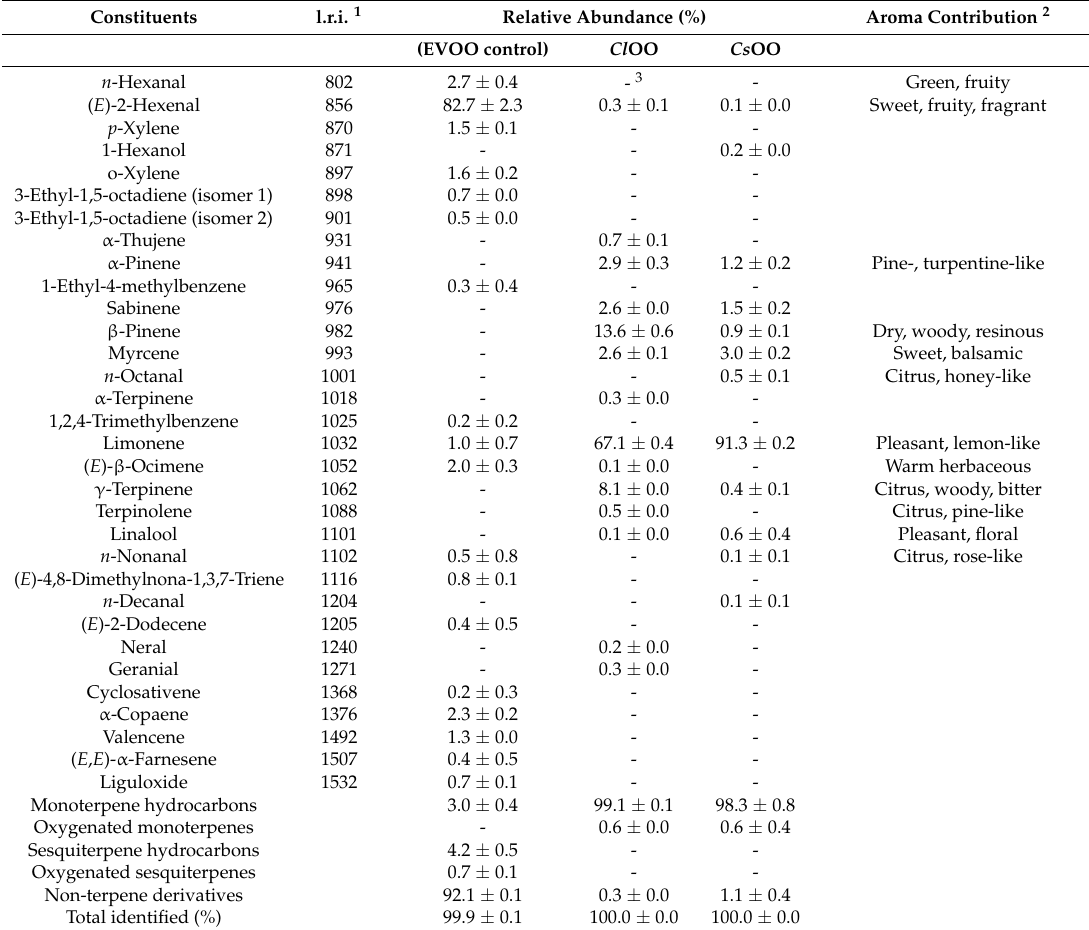
Table 3. Complete headspace compositions of the lemon olive oil ( Citrus limon olive oil Cl OO) and orange olive oil ( Citrus sinensis olive oil Cs OO) compared to the unflavoured extra-virgin olive oil (EVOO